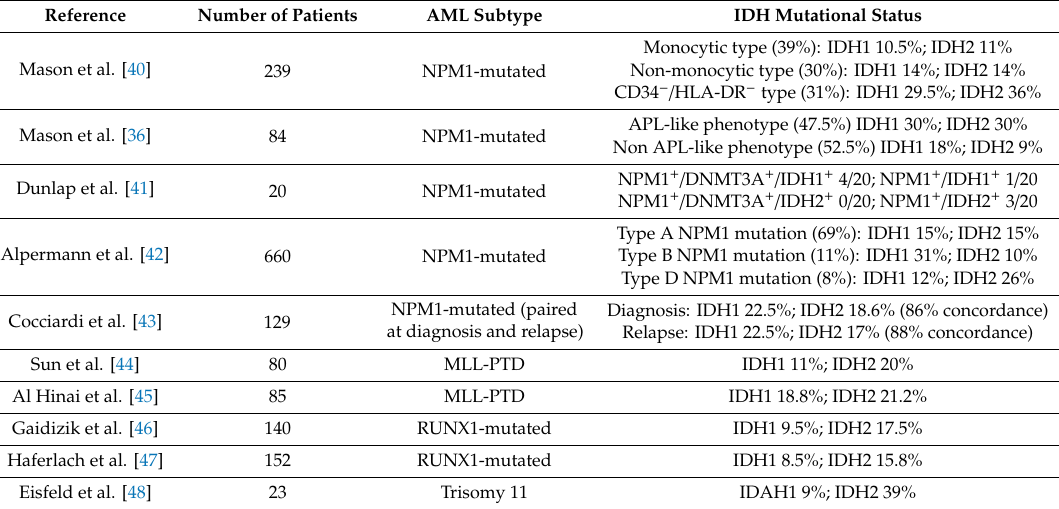
Table 1. IDH1 and IDH2 mutations in AML